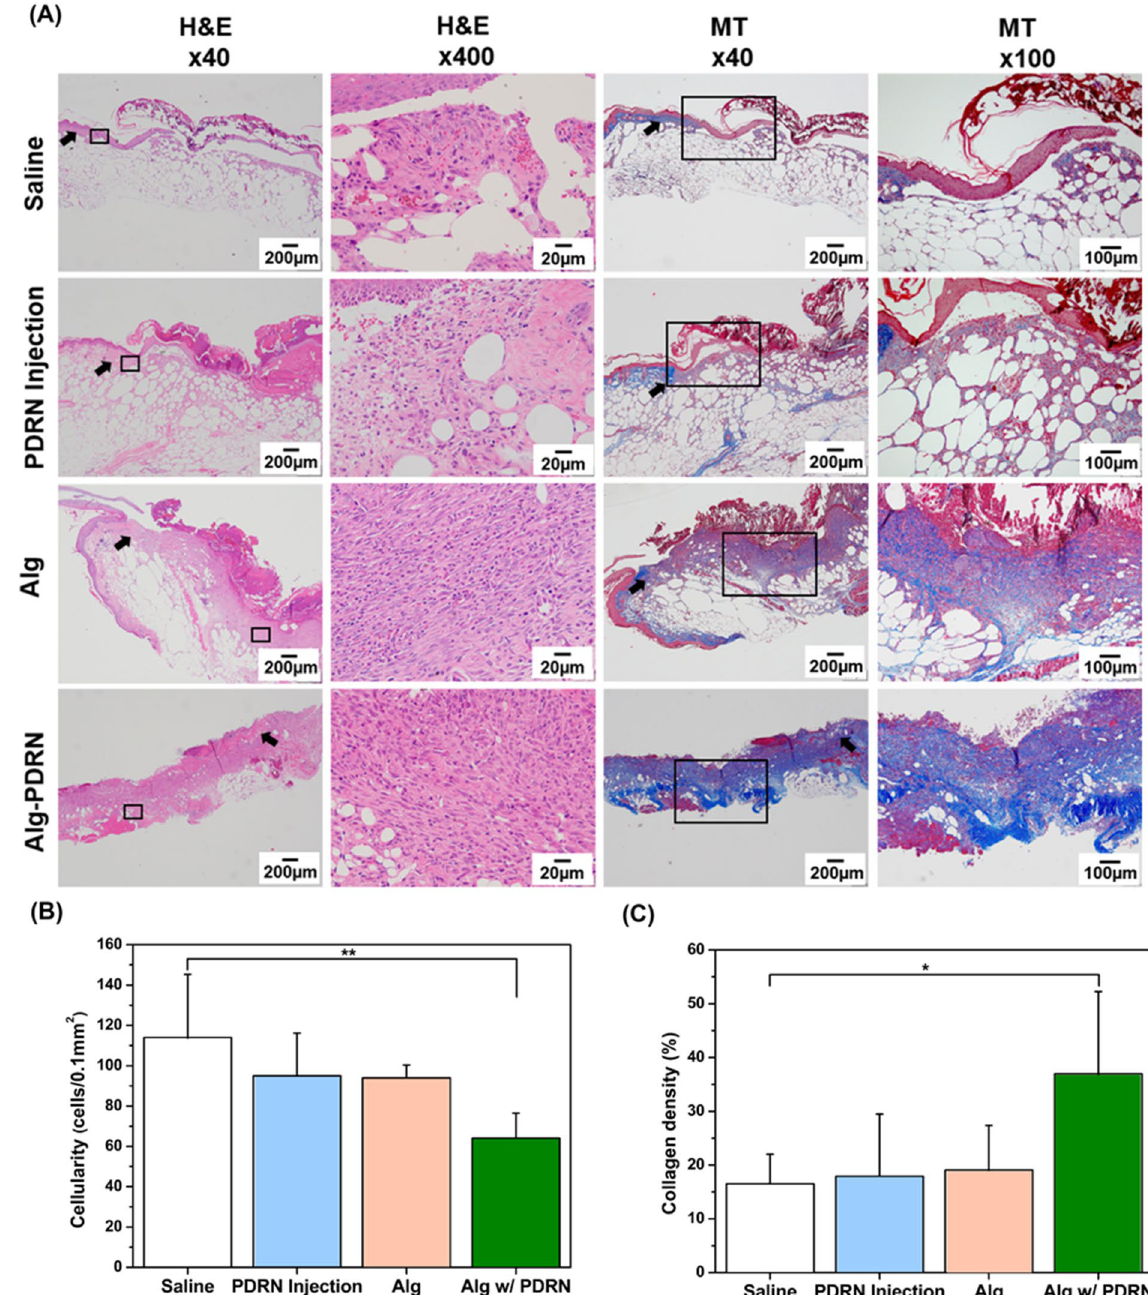
Figure 7. Histological examination of the wound region after 14 days of treatment: ( A ) representative H&E staining (Original magnification: X40—Scale bar = 200 µm, original magnification: X400—Scale bar = 20 µm) and MT staining images (Original magnification: X40—Scale bar = 200 µm, original magnification: X100—Scale bar = 100 µm) of the wound region and ( B ) quantitative analysis of cellularity and collagen density (* p < 0.05, ** p < 0.005) (MT: blue—collagen, red—keratin/muscle fiber) (arrow: wound